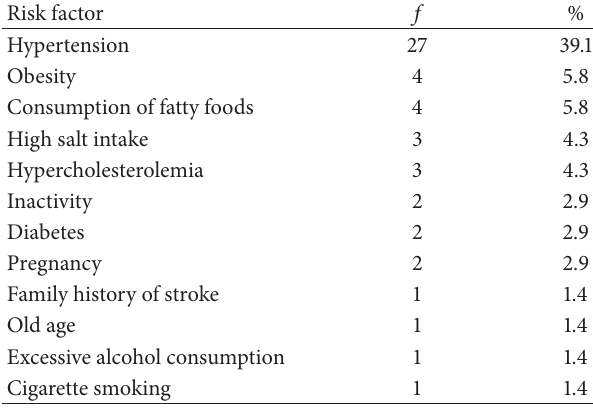
Table 2: Correct risk factors mentioned by participants ∗ .